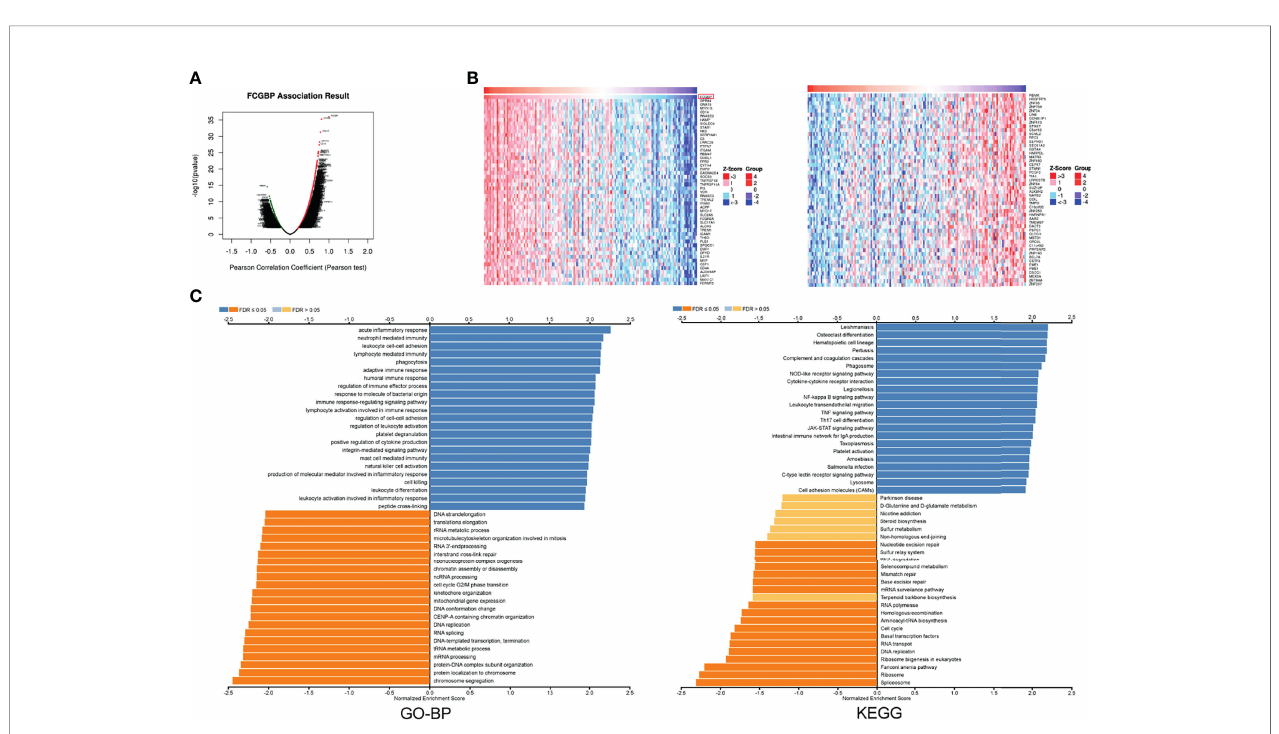
FIGURE 5 | FCGBP co-expression network in glioma (A) The volcano map showed FCGBP-related genes in glioma. (B) The heatmap showed FCGBP-related genes in glioma. (C) Based on the LinkedOmics database, GO annotations and KEGG pathways of genes co-expressed with FCGBP in glioma were signi fi cantly